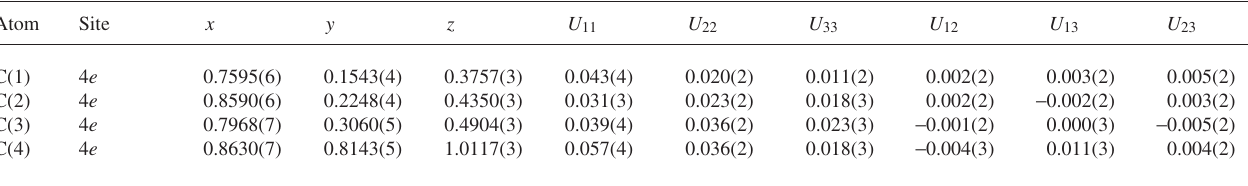
Table 3. Atomic coordinates and displacement parameters (in Å 2 )